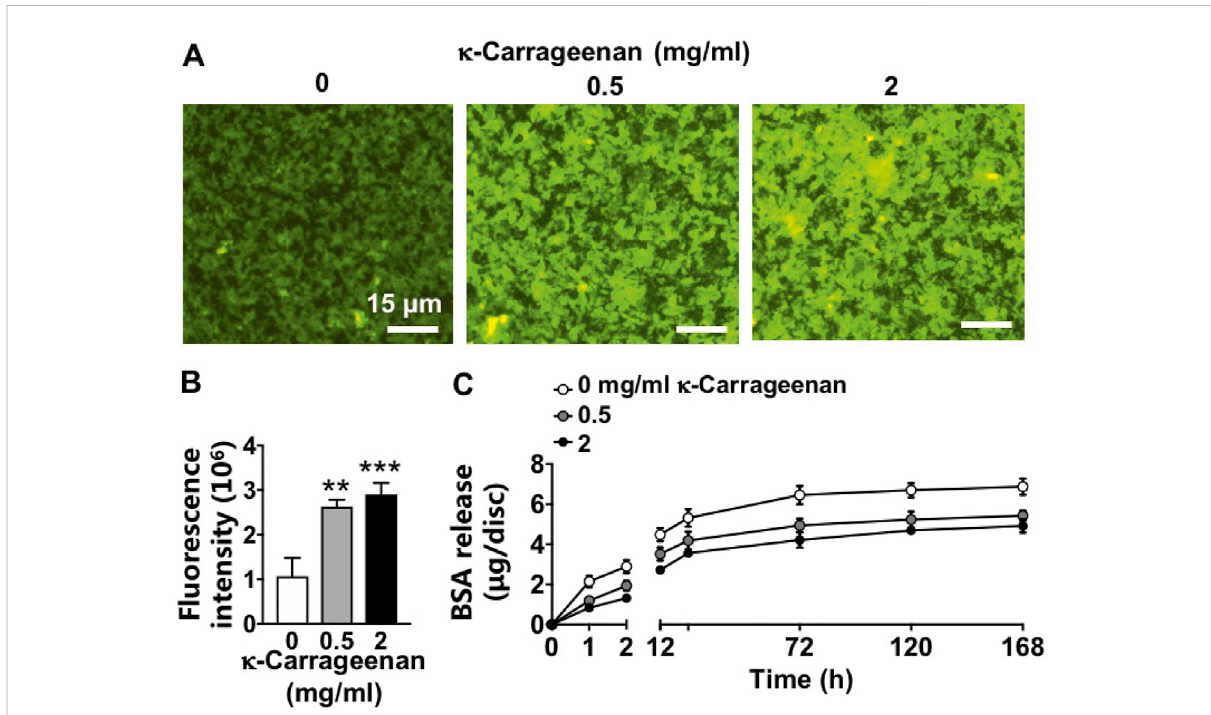
FIGURE 3 Effectofincreasing κ -carrageenanconcentrationinOCP-coatingoftitaniumdiscsonBSAreleasefromOCP-coatinguptoday7.Totalamount of initial BSA incorporated per disc: 10 µg. (A) Fluorescent images of FITC-BSA on the surface of OCP-coating. (B) Quanti fi cation of fl uorescence intensity on the surface of OCP-coating. (C) BSA release pro fi le. Values are mean ± SD. n = 3 from 3 independent experiments. BSA, bovine